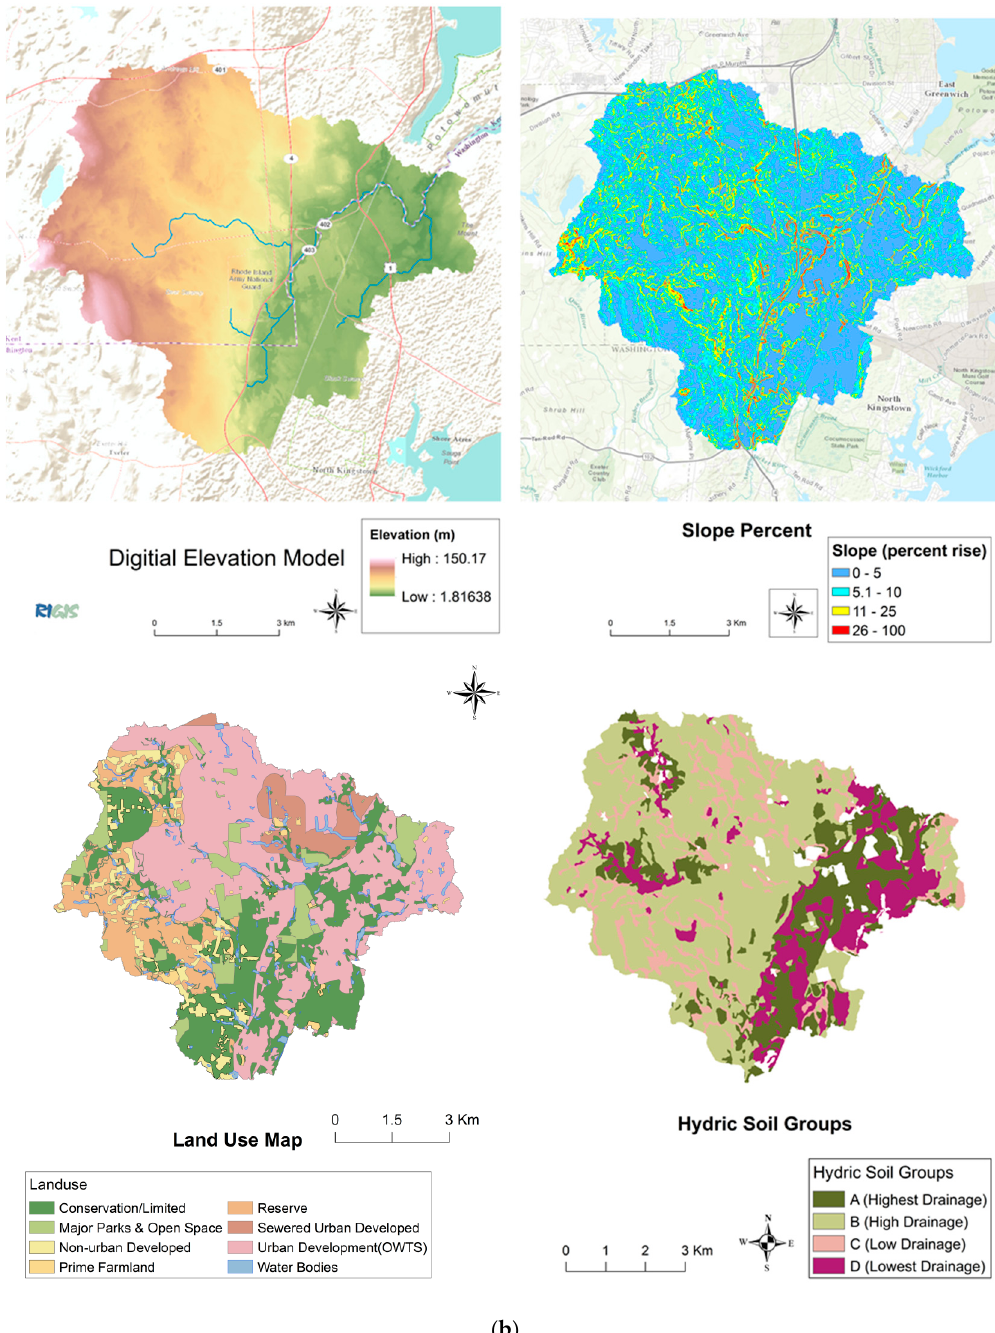
Figure 1. Figure 1 shows the Hunt River Watershed as delineated by the Soil and Water Assessment Tool (SWAT) model: ( a ) The Hunt River Watershed delineated into six subbasins; ( b ) The Digital Elevation Model, Slope Percent, Land Use, and Hydric Soil Groups for the Hunt River Watershed.